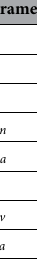
The numerical values of the constant PD states that occur between the AP-NTS (blue) and AP-4Vep (orange) are plotted in Fig. 2C. For the AP-NTS, a small PD around zero ( 0.55 ± 1.06 h) is (semi) stable, and for the AP-4Vep, constant PDs arise at higher values ( 10.9 ± 2.95 h). In one case, the constant AV-PD is negative. The period of each oscillator during a constant PD state is calculated and averaged in time. The difference in period between two oscillators whilst their PD is constant is always less than 4% (Supplementary Figs. S3 and S4) and so the collective period of the coupled oscillators is defined as the average of the two individual periods. The collective periods of the coupled oscillators when their PD is constant ( τ ∗ an and τ ∗ an ) are displayed in Fig. 2D. Each period is a compromise between the intrinsic periods of the two participating oscillators. The intrinsic periods, constant PD states and their corresponding collective periods are used to estimate model parameters, which are plotted in Fig. 2E. Model intrinsic period parameters are averages of those calculated in Fig. 2B. Analysis of AP‑NTS‑4Vep coupled oscillator model. Starting from the fully synchronised AP-NTS-4Vep system using the parameter values in Table 1, we examine the effect of reducing the coupling by introducing a global coupling parameter s such that K ij → sK ij , for all i , j . Reducing s is analogous to reducing all of the coupling parameters by the same fraction, and the result of varying the overall coupling strength is seen in Fig. 3. For strong coupling (insert (i)) the system quickly decays from its initial conditions to its steady state. The bifurca- tion diagram shows that as the coupling decreases, the steady state for both θ an and θ av decrease along a parabolic curve. Associated with lower coupling strength is a decrease in decay rate (insert (ii)). The model has a fold bifur-